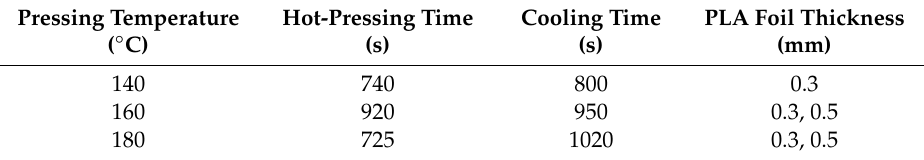
Table 1. Nominal hot-pressing and cooling times for birch and spruce 5-ply laminate assemblies at di ff erent pressing temperatures and poly(lactic acid) (PLA) foil thicknesses. Pressing Temperature Hot-Pressing Time Cooling Time ( ◦ C) (s)